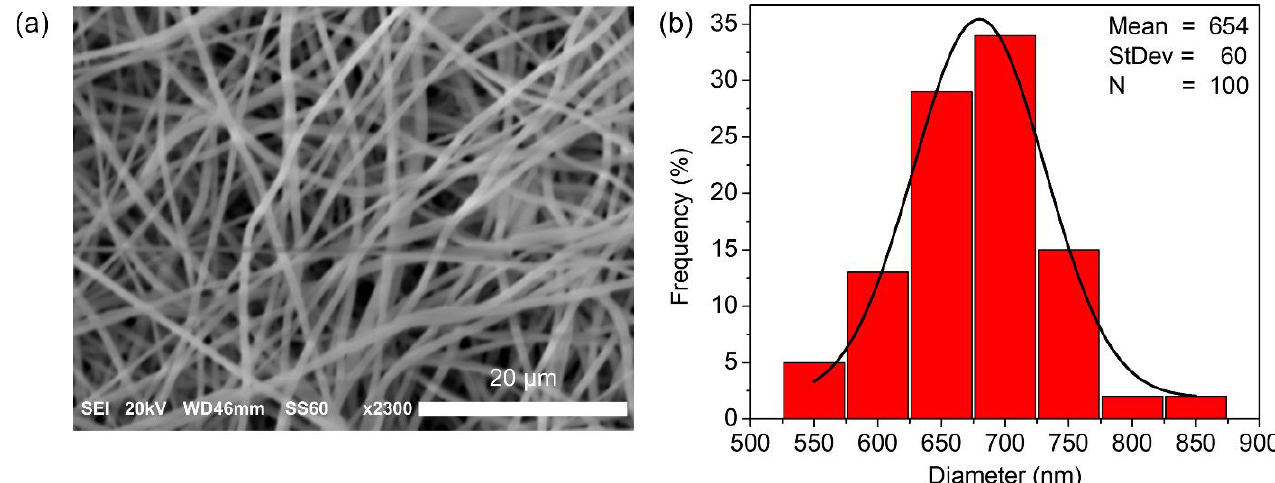
Figure 2. ( a ) SEM images and ( b ) diameter distribution histogram of the nanofibers.